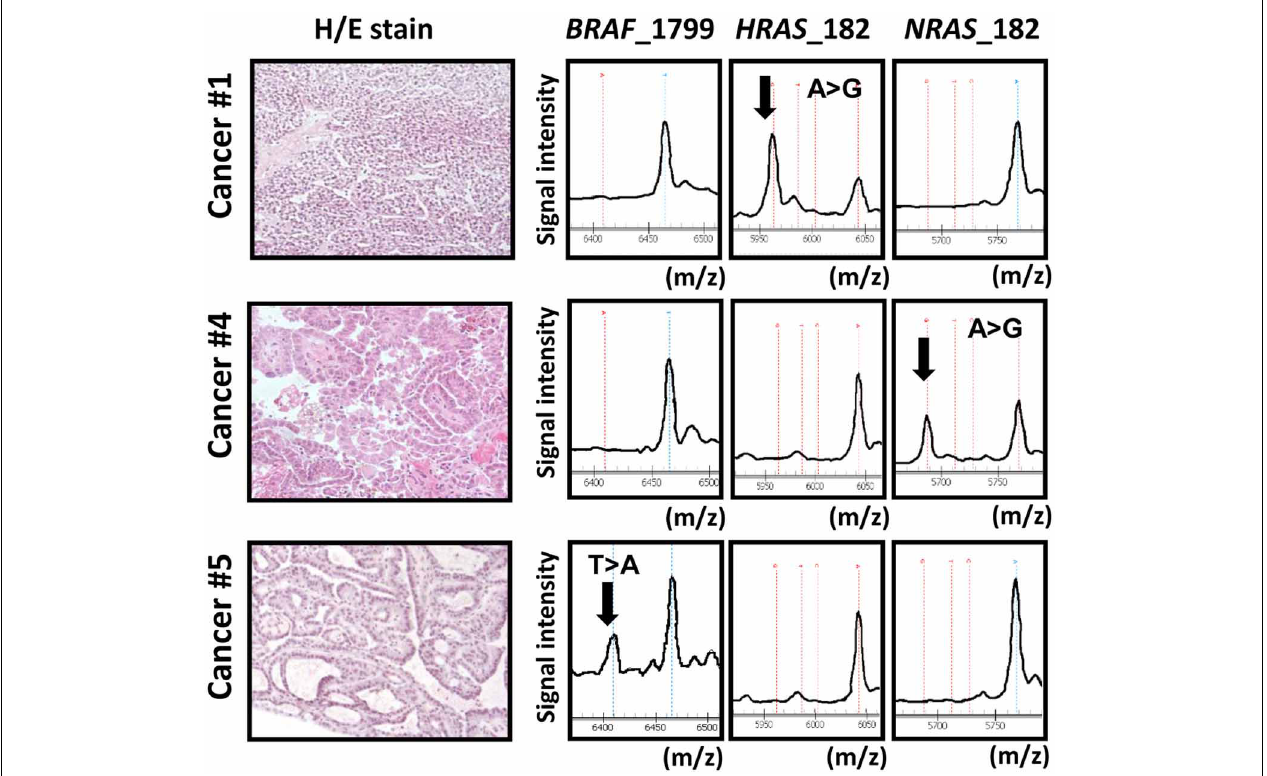
FIGURE 1 | Representative data obtained from MALDI-TOF-MS imaging for three cancer samples. Cancer samples #1, #4, and #5 correspond to papillary cancer samples #1, #4, and #5 in Figure 3 . First column: photomicrograph of a tumor section with